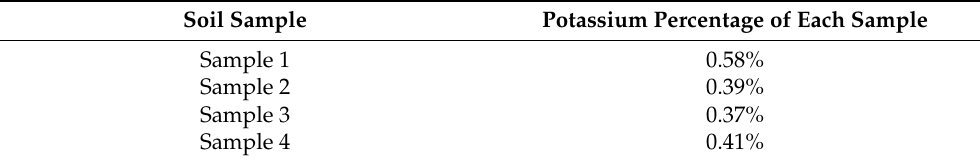
Table 5. The potassium percentage of the soil samples after 21 days decomposition of